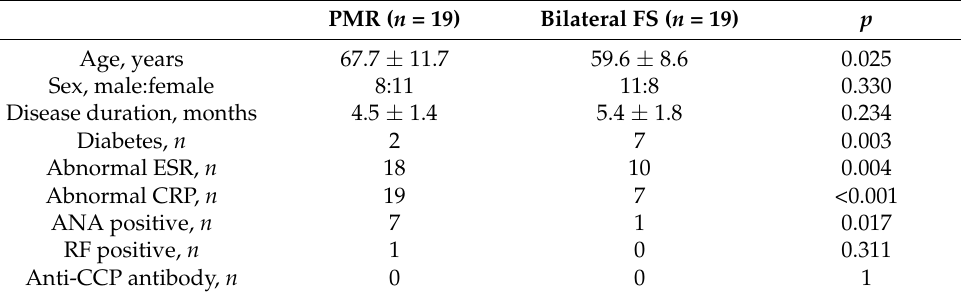
Table 1. Demographic and clinical characteristics of the PMR and bilateral FS